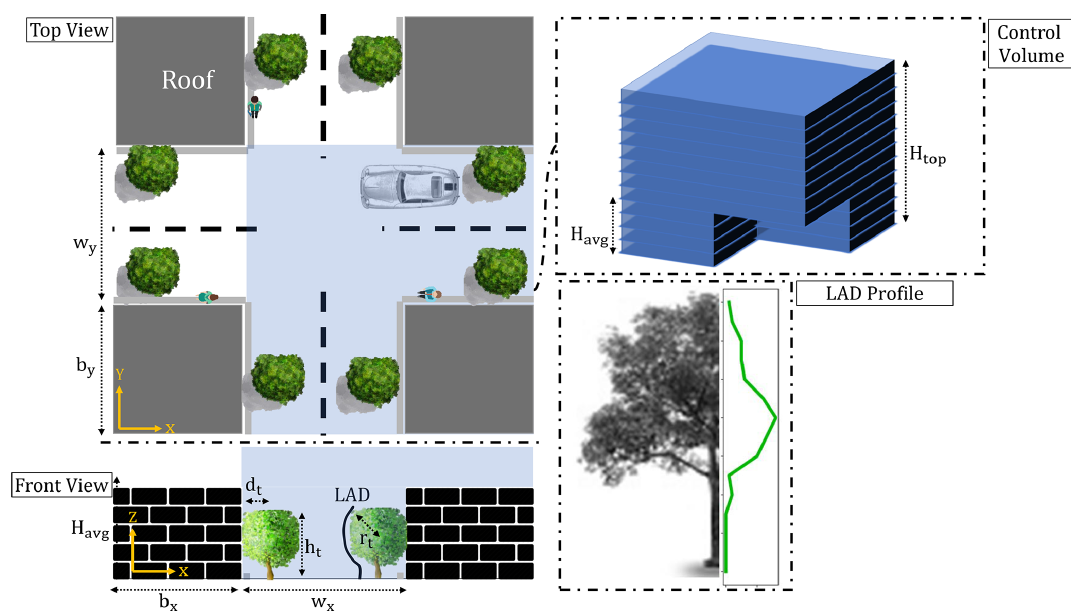
Figure 2. Simplified urban area used in VCWG and corresponding layers of control volumes within and above the canyon. The height of the domain is 3 times the average building height. A leaf area density (LAD) (m 2 m − 3 ) profile is considered to represent